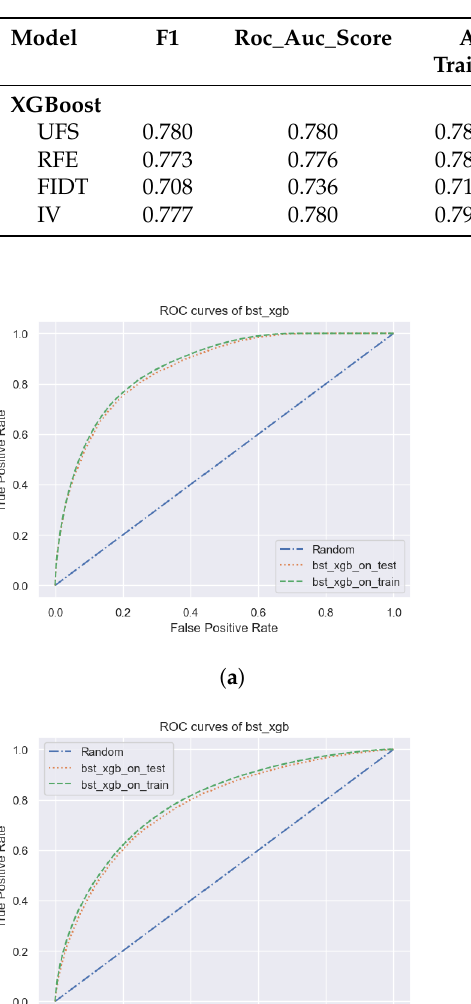
Table 2. Performance of 4 XGBoost models.